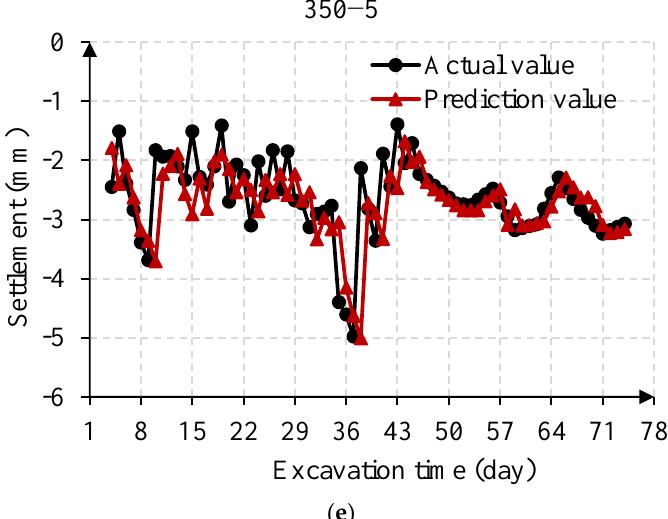
Figure 7. Comparison of actual values and prediction values of ground settlements at five settlement observation points: ( a ) 350 – 1, ( b ) 350 – 2, ( c ) 350 – 3, ( d ) 350 – 4, ( e ) 350 – 5.